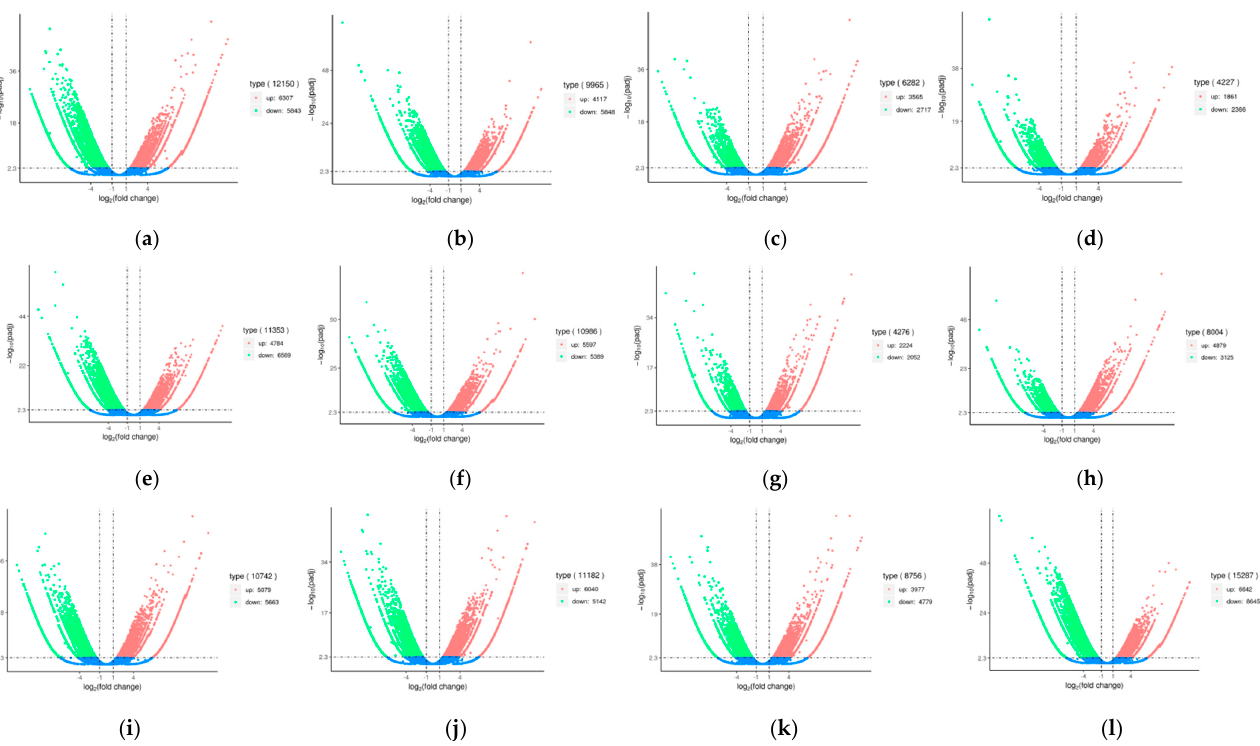
Figure 5. Volcano plots of differentially expressed genes between pairwise comparison samples. ( a ) ‘TRI-2025 ′ vs. ‘Tambi-2 ′ ; ( b ) ‘Tambi-2 ′ × ‘Suka Ati’ vs. ‘Tambi-2 ′ ; ( c ) ‘Tambi-2 ′ × ‘Cinyiruan-143 ′ vs. ‘Tambi-2 ′ ; ( d ) ‘Tambi-2 ′ × ‘TRI-2025 ′ vs. ‘Tambi-2 ′ ; ( e ) ‘Kiara-8 ′ × ‘Sukoi’ vs. ‘Tambi-2 ′ ; ( f ) ‘Tambi-1 ′ × ‘Kiara-8 ′ vs. ‘Tambi-2 ′ ; ( g ) ‘Tambi-2 ′ × ‘TRI-2025 ′ vs. ‘Tambi-2 ′ × ‘Suka Ati-40 ′ ; ( h ) ‘Tambi-2 ′ × ‘Cinyiruan-143 ′ vs. ‘Tambi-2 ′ × ‘Suka Ati-40 ′ ; ( i ) ‘Tambi-2 ′ × ‘TRI-2025 ′ vs. ‘Tambi-2 ′ × ‘Cinyiru- an-143 ′ ; ( j ) ‘Tambi-2 ′ × ‘Suka Ati-40 ′ vs. ‘Kiara-8 ′ × ‘Sukoi’; ( k ) ‘Kiara-8 ′ × ‘Sukoi’ vs. ‘Tambi-2 ′ × ‘TRI-2025 ′ ; ( l ) ‘Kiara-8 ′ × ‘Sukoi’ vs. ‘Tambi-2 ′ × ‘Cinyiruan-143 ′ .